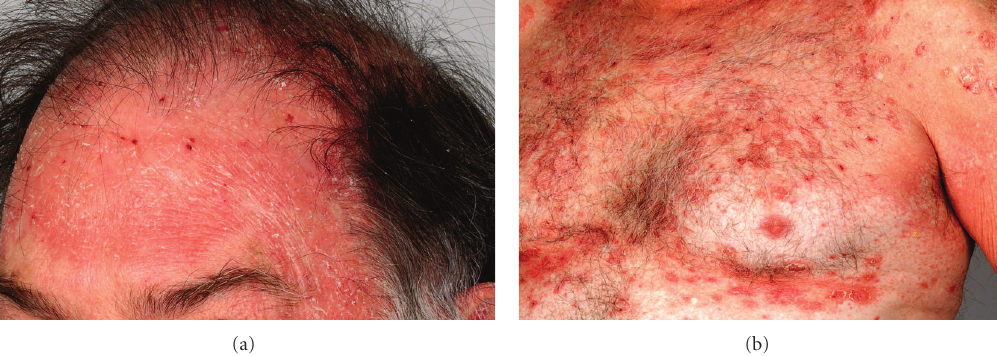
Figure 1: (a) Salmon-colored erythematous plaques with superficial thin scales involving the left temple site where imiquimod 3.75% was applied and extending over forehead, scalp, and ear. (b) Small, perifollicular, salmon-colored papules coalesce to form a background of erythema, with islands of sparing over chest. There are overlaying, prominent, erythematous oval plaques with flaky scale.